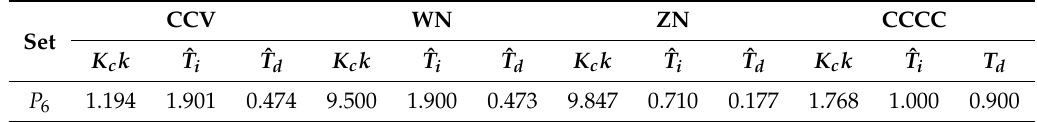
Table A11. Controller parameters for set P 6 .